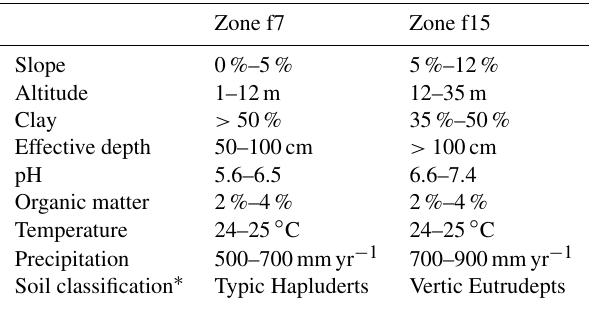
Table 5. Soil and climatic characteristics of agro-ecological homo- geneous zones AHZs in